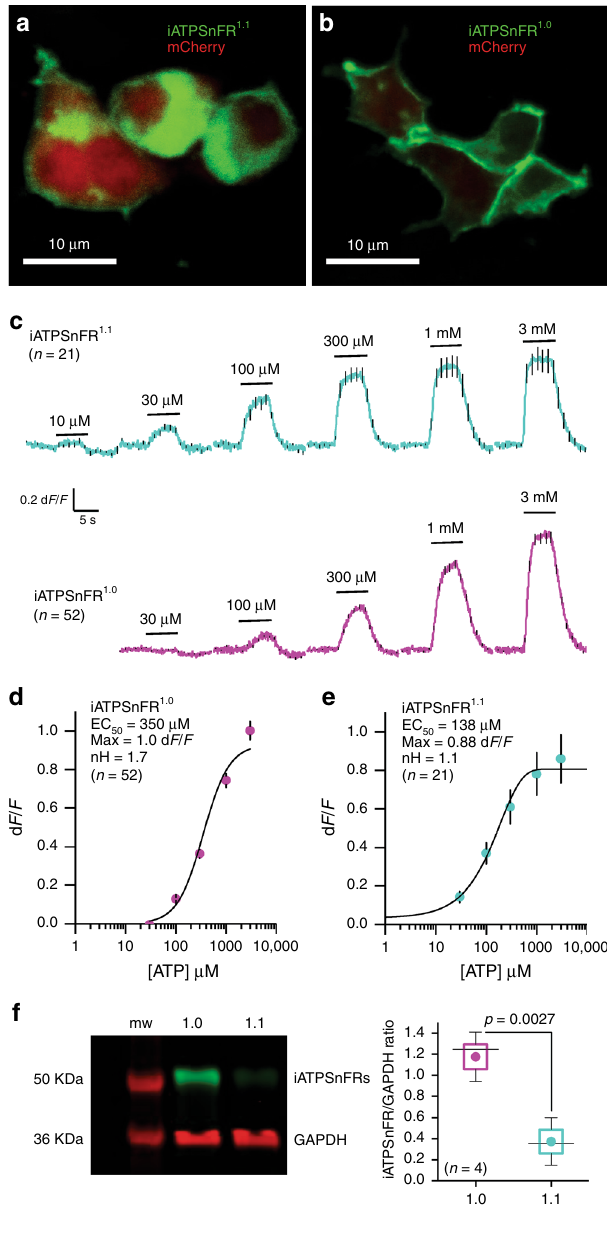
(Fig. 5d), similar to the HEK293 cell data. In hippocampal neu- rons, iATPSnFR 1.0 properly localized to membrane processes, and application of ~1 mM ATP evoked increases in fl uorescence.